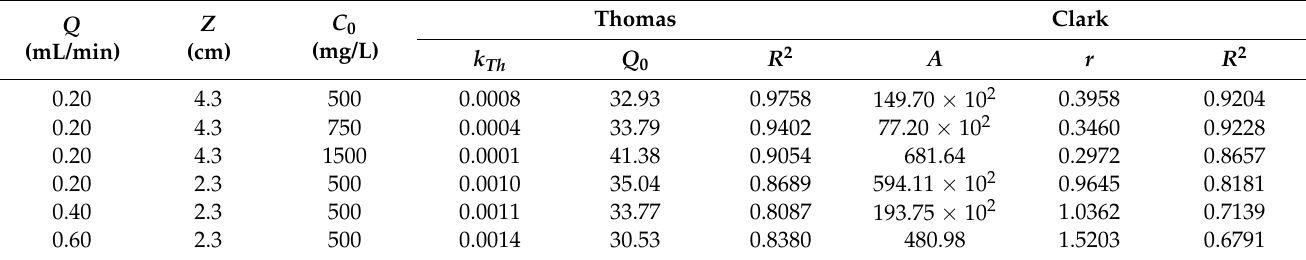
Table 2. Kinetic model constants of the Thomas model and the Clark model on the adsorptive removal of Pb(II) from aqueous solution using